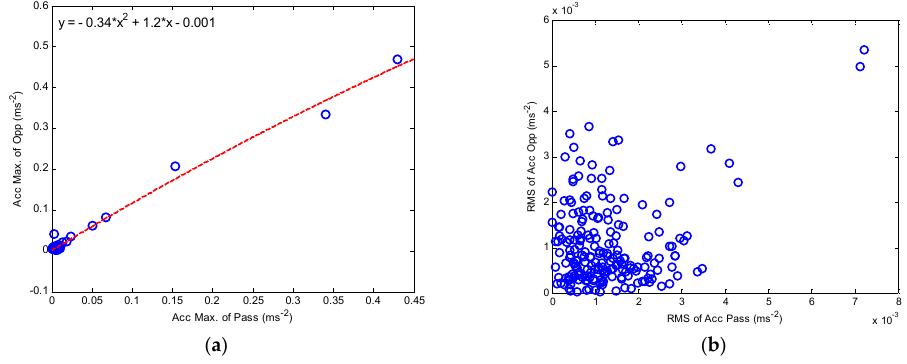
Figure 7. Cross-correlation between the passage and opposite way responses for 360 km/h. ( a ) cross-correlation maximum acceleration; ( b ) cross-correlation roote mean square (RMS) acceleration.